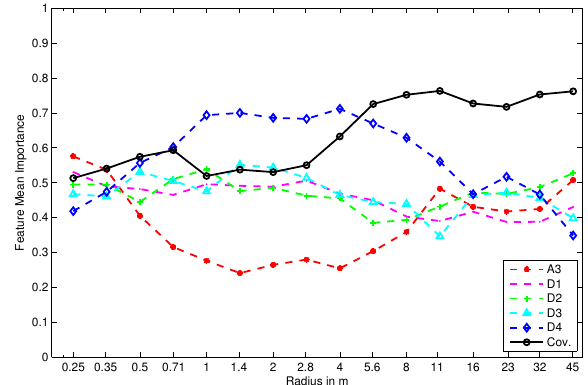
Figure 4: Classwise mean Shannon entropy calculated according to Equation 8 for different neighbourhood sizes.